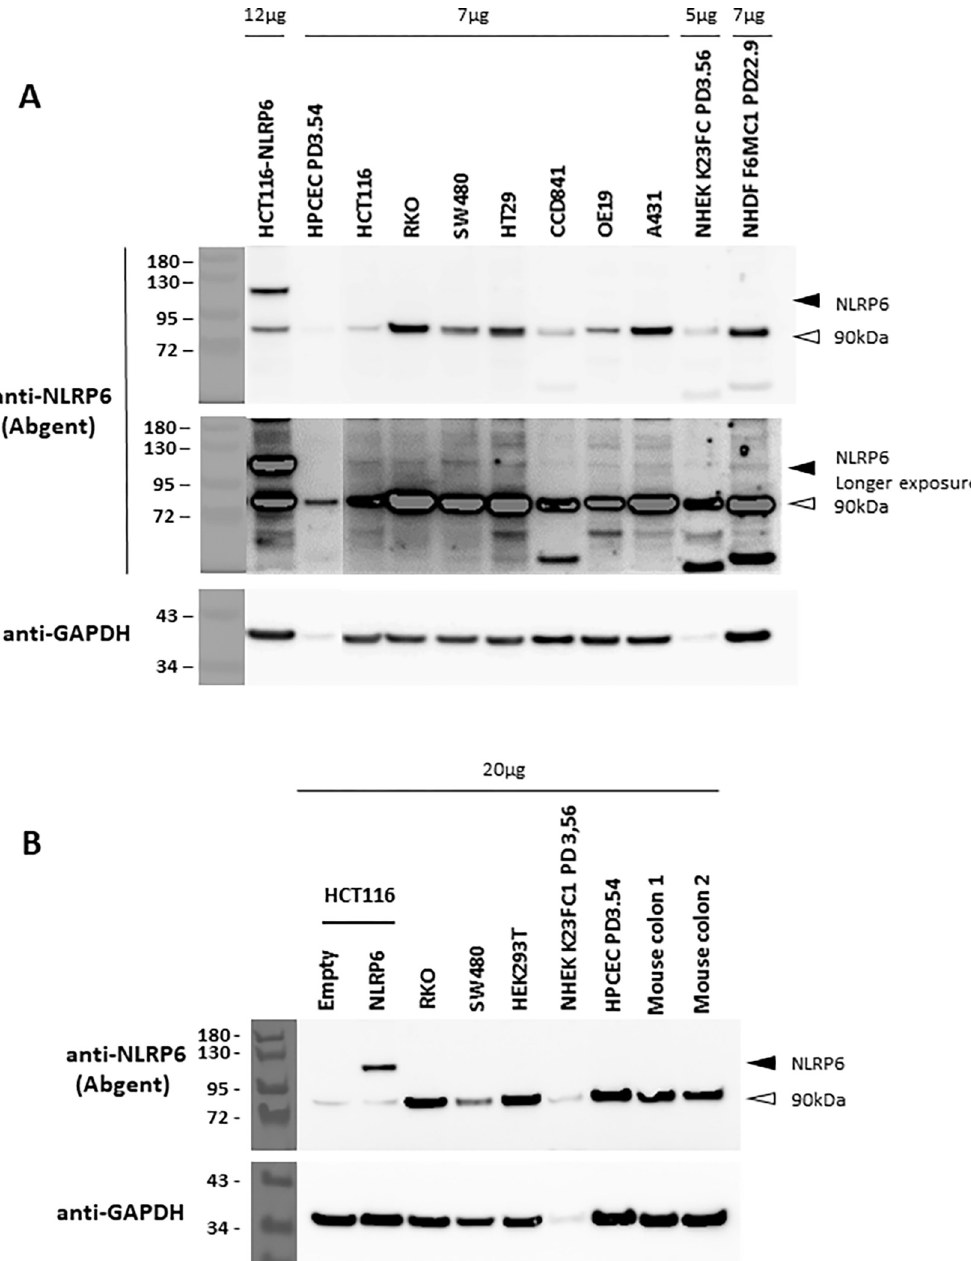
Fig 2. The endogenous NLRP6 expression is barely detected in several human and mouse cell types by western-blotting using an antibody from ABGENT. (A) Western-blot analysis of extracts of HCT116 cells transiently transfected by the FLAG-NLRP6-expressing pCDNA3.1+ vector, and of a series of various non-transfected cell lines. The upper image corresponds to a short exposure and the lower image to a longer exposure. (B) Western-blot analysis of the same extracts as in A and total mouse colon extracts. The migration position of NLRP6 is indicated with a dark arrowhead. The white arrowhead points a non-specific band et 9OkDa. The amount of loaded total proteins is indicated for each